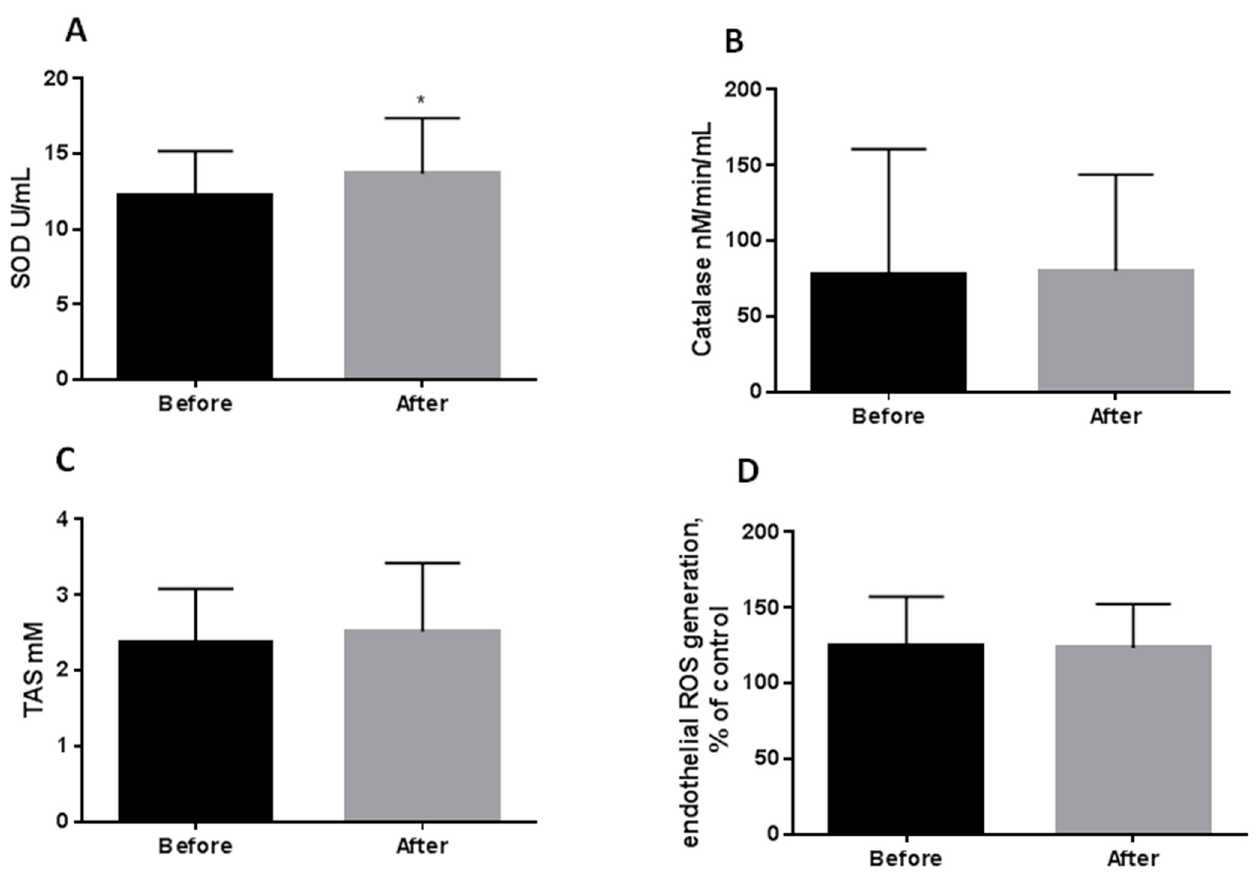
Figure 2. Effect of 8 weeks caloric restriction on serum superoxide dismutase activity ( A ), catalase activity ( B ), total antioxidant status ( C ), and reactive oxygen species generation by endothelial cells cultured in vitro ( n = 2) in medium supplemented with serum taken from obese patients before and after eight weeks of caloric restriction ( D ). The data were analyzed using the paired t -tests (Gaussian distribution: the paired test; non-Gaussian distribution: Wilcoxon test). Significance difference Before vs After * p < 0.05; Abbreviations: SOD—superoxide dismutase, TAS—total antioxidant status, ROS—reactive oxygen species.